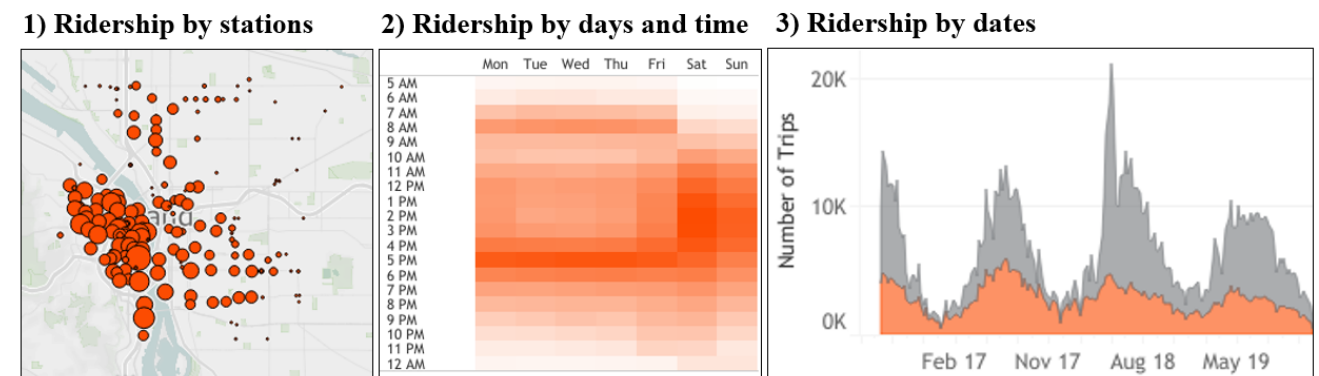
Figure 3. Ridership of Biketown during the study period (Source: https://www.biketownpdx.com/system-data/historical) (accessed on 10 June 2022).